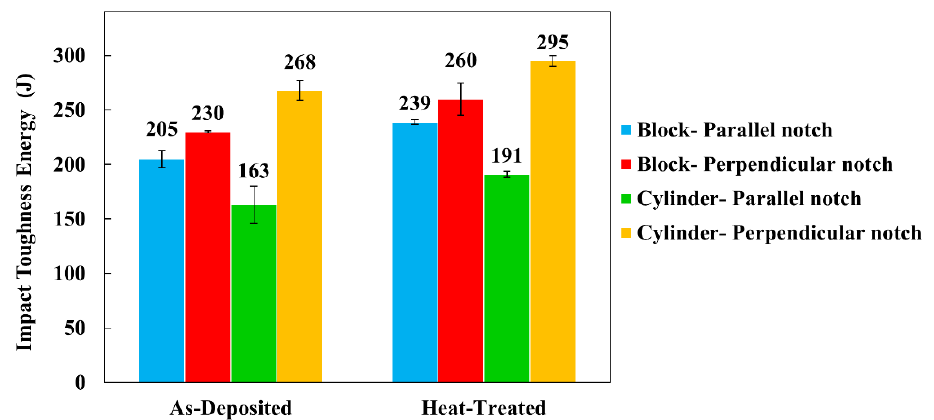
Figure 9. The Charpy impact toughness energy of DSS block and cylinder. Samples with notch perpendicular and parallel to the deposition direction. A notch perpendicular to deposition direction and heat treatment resulted in higher impact